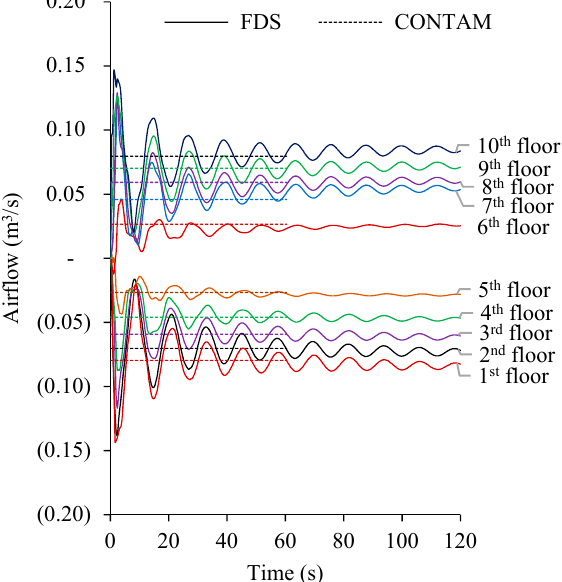
Figure 10. CONTAM and Fire Dynamics Simulator (FDS) results for airflow at vertical shafts, simulation: tight stairwell and leaky envelope.